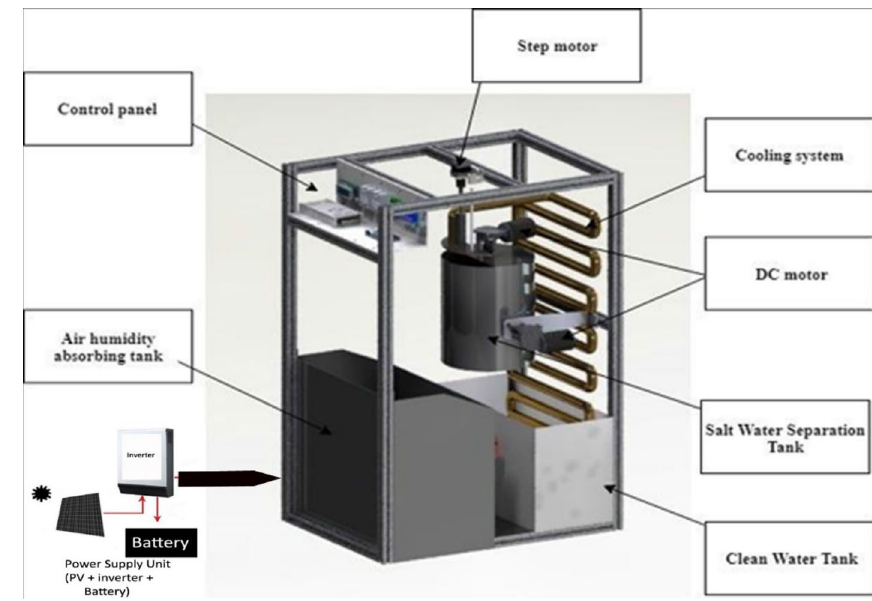
Fig. 1 Design of the machine